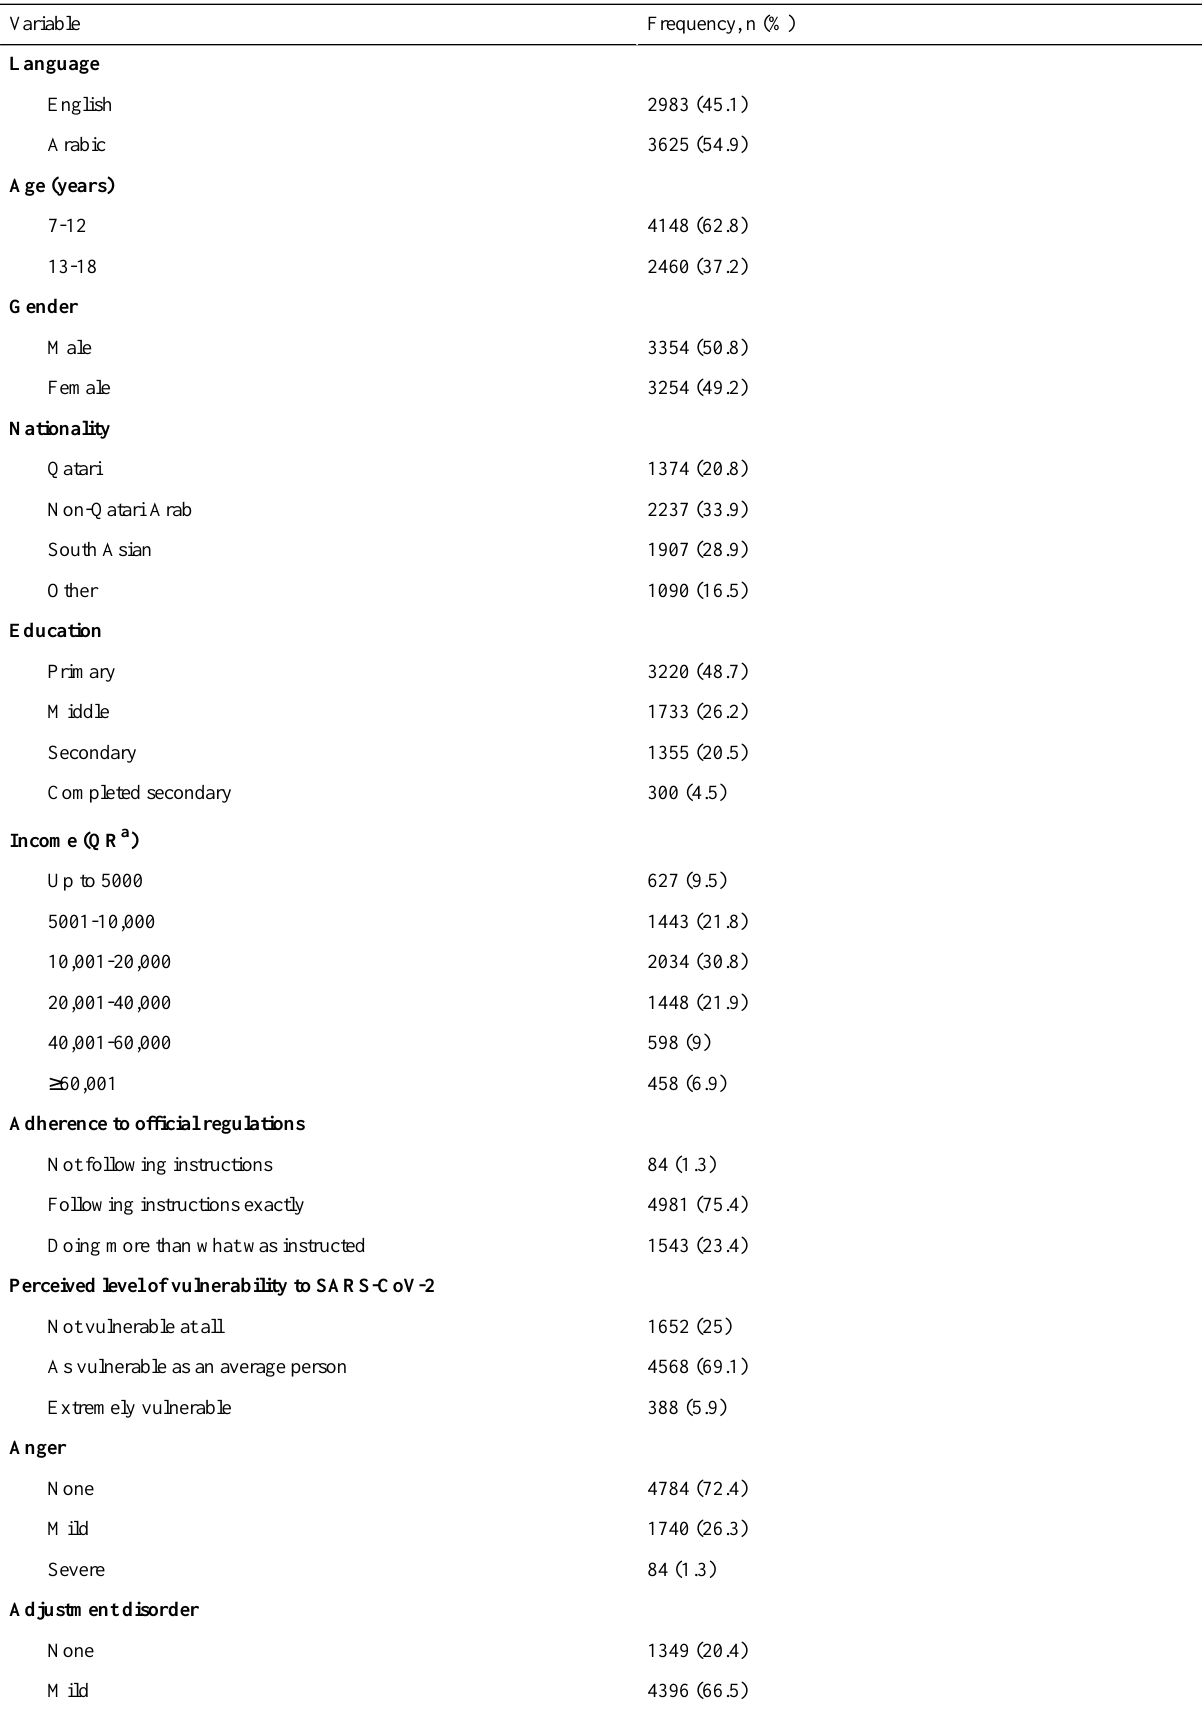
Table 1. Frequency distribution of sociodemographic characteristics, final psychological diagnoses, and coping strategies used among children